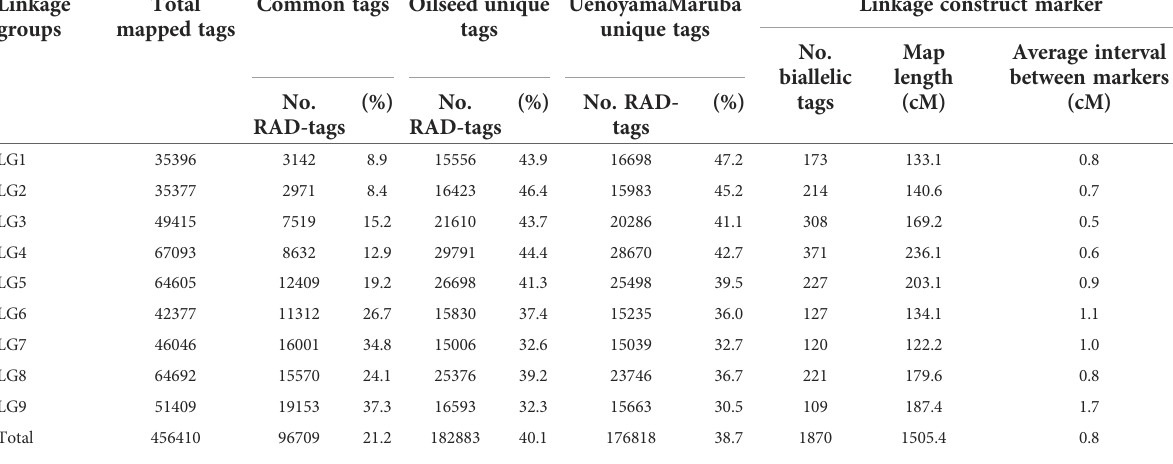
TABLE 4 Summary of integrated lettuce linkage groups and genetic map information. Linkage Total Common tags Oilseed unique groups mapped tags